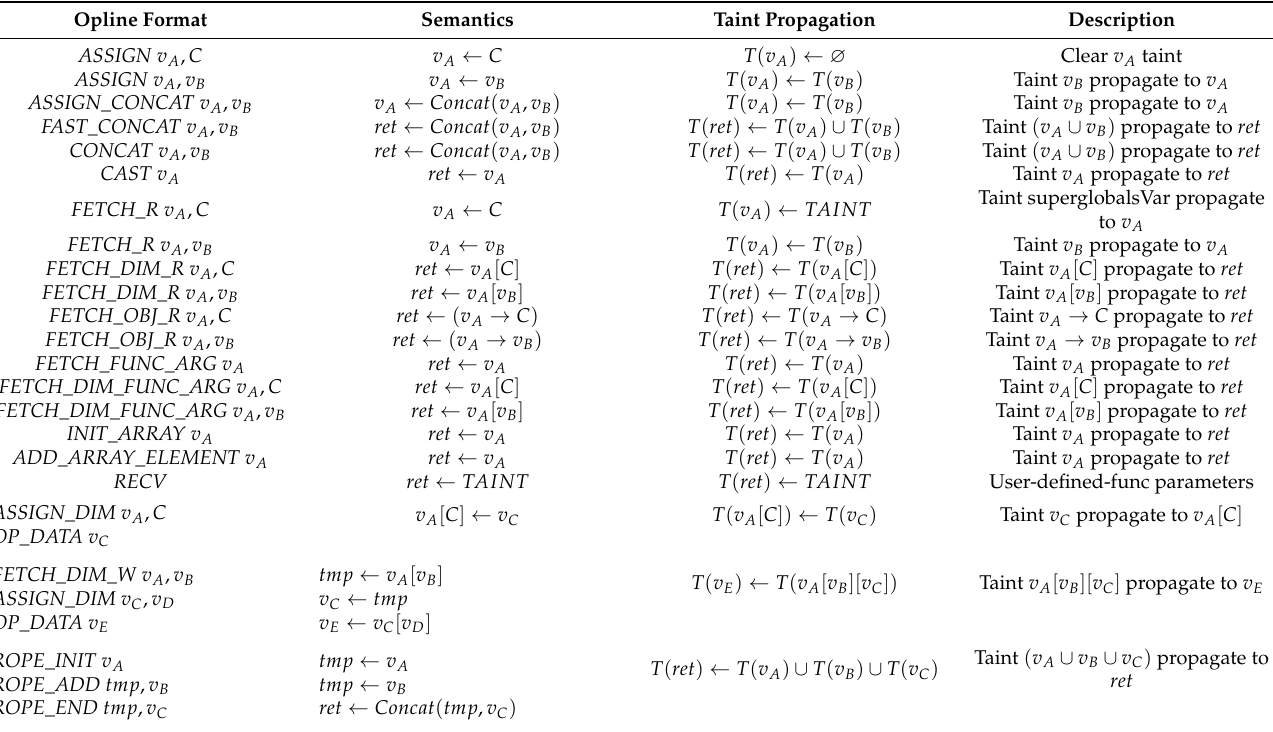
Table 1. Taint propagation logic.